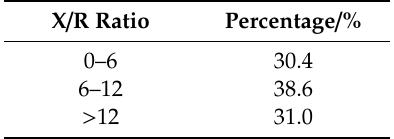
Table 6. The X / R ratio of the lines of the PEGASE 89 bus